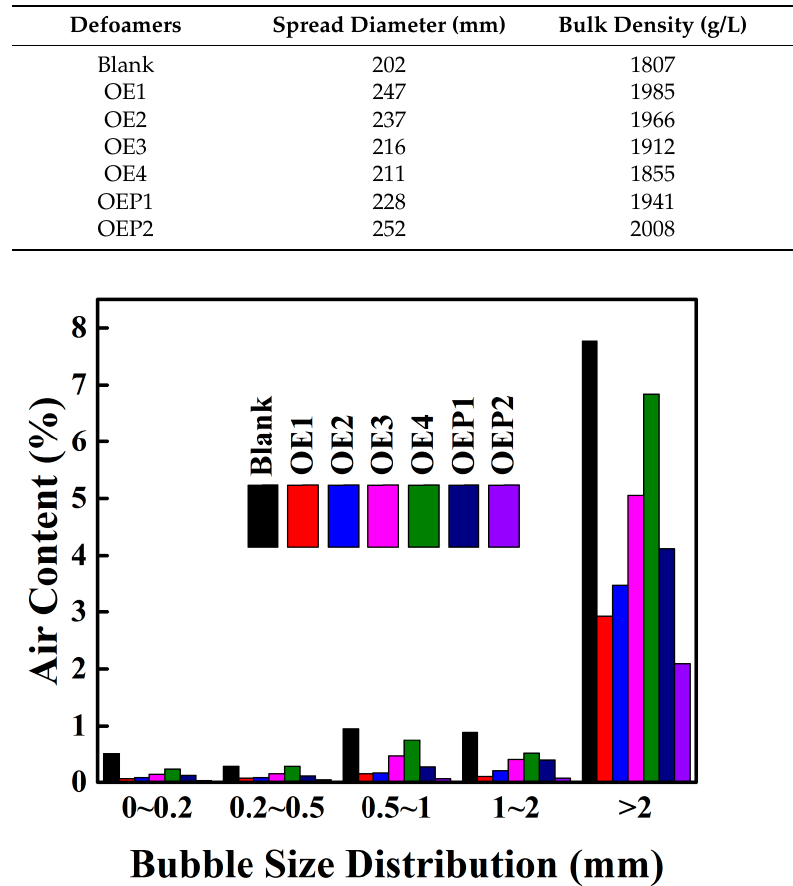
Figure 7. The bubble size distribution of the fresh mortar samples mixed with various defoamers.